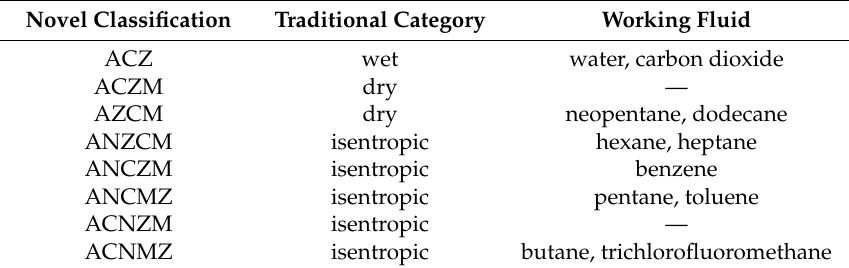
Table 1. Examples of the new